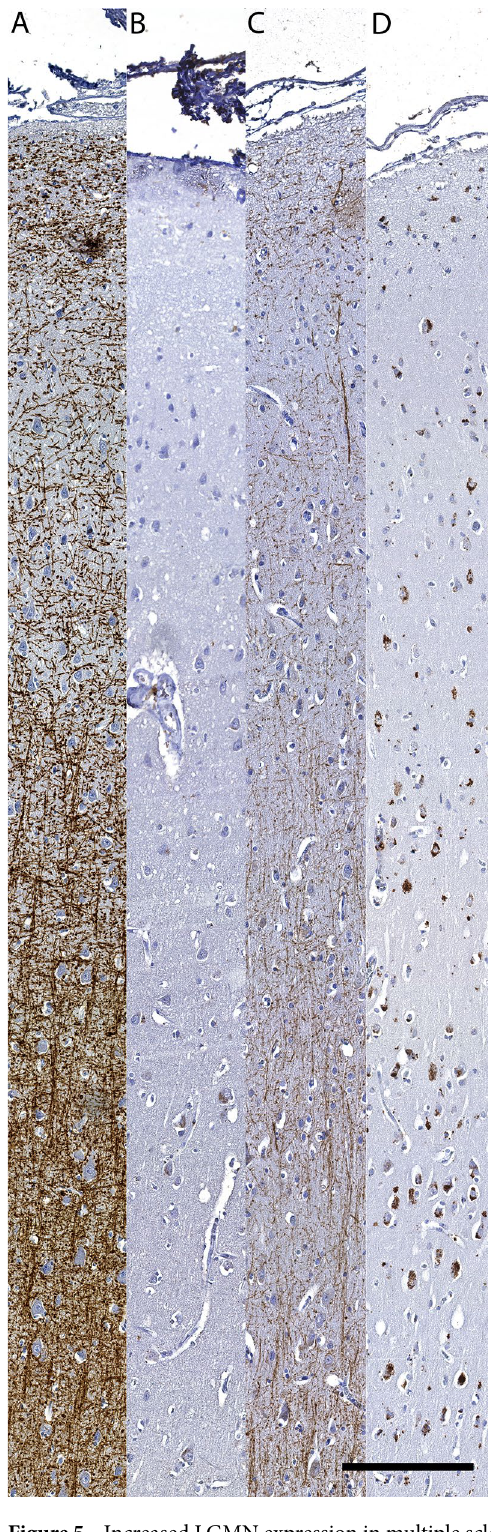
Figure 5. Increased LGMN expression in multiple sclerosis normal appearing cerebral cortex. LGMN ( A,B ) and myelin (C,D ) immunostaining of cortex from a multiple sclerosis case ( B,D ) and control ( A,C ). Throughout all cortical layers there is reduced myelin content, and an increase in LGMN immunopositivity. Scale bar 200